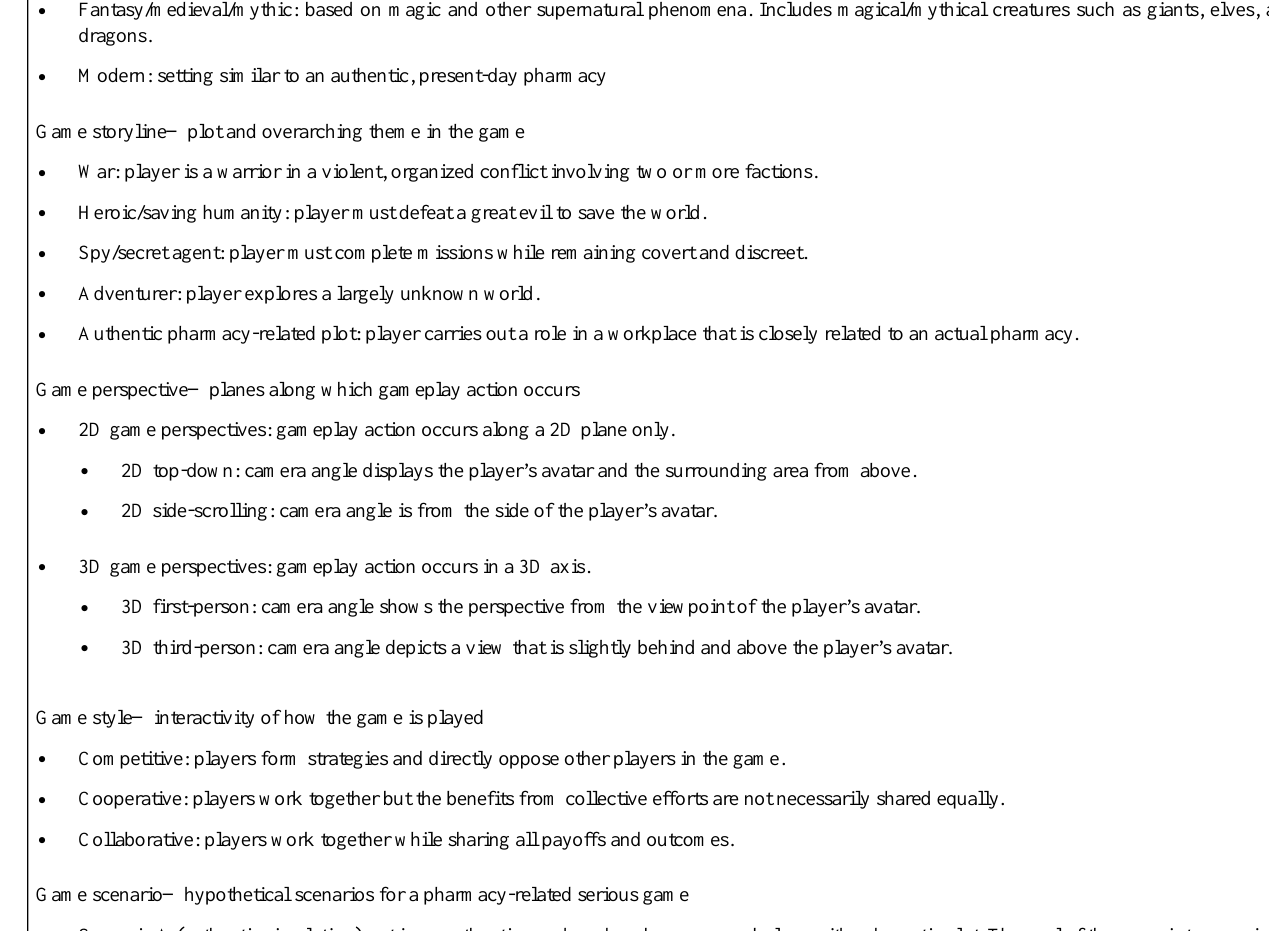
Game style—interactivity of how the game is played